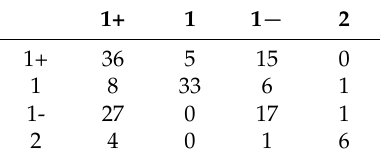
Table 10. Confusion-Matrix of tree vitality classification by MLS data.